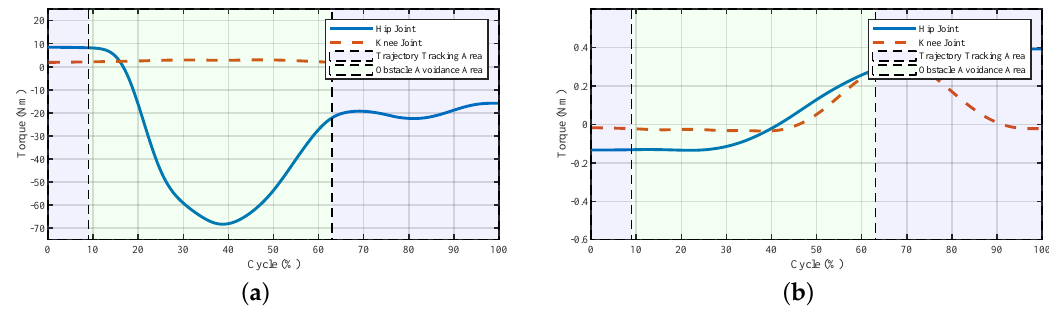
Figure 14. Joint torques of the system during stepping over a ball-like obstacle. ( a ) Torques of the exoskeleton and ( b ) torques of the